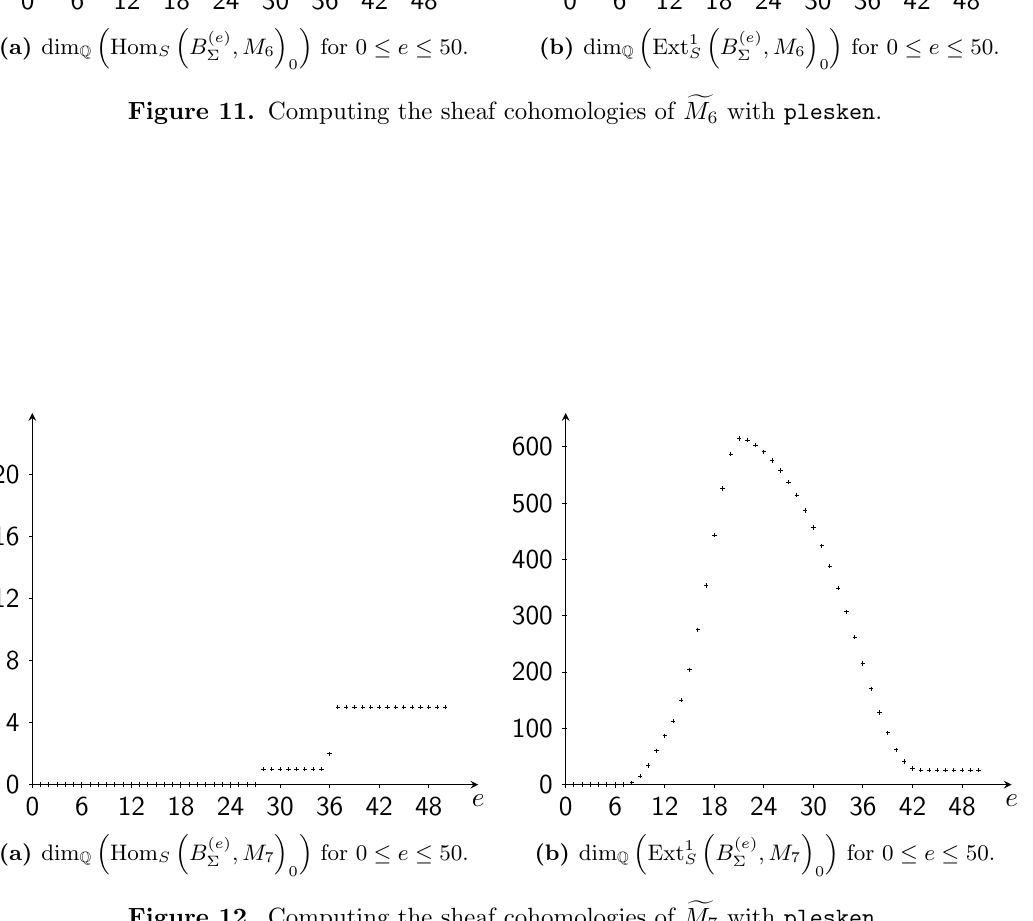
Figure 12. Computing the sheaf cohomologies of f M 7 with plesken